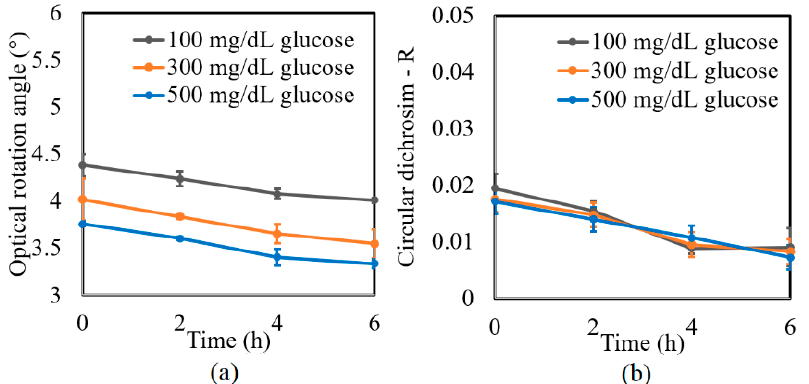
Figure 5. Experimental results for variation in: ( a ) γ and ( b ) R of glucose tissue phantom solutions mixed with 2000 mg/dL of albumin over time interval of 6 h.